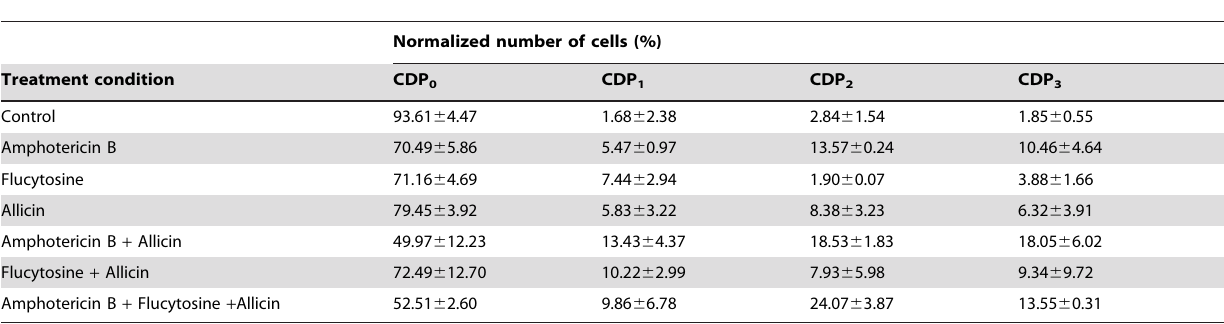
Table 2. The normalized number of cells at different cell death phases (CDP) according to treatment condition.